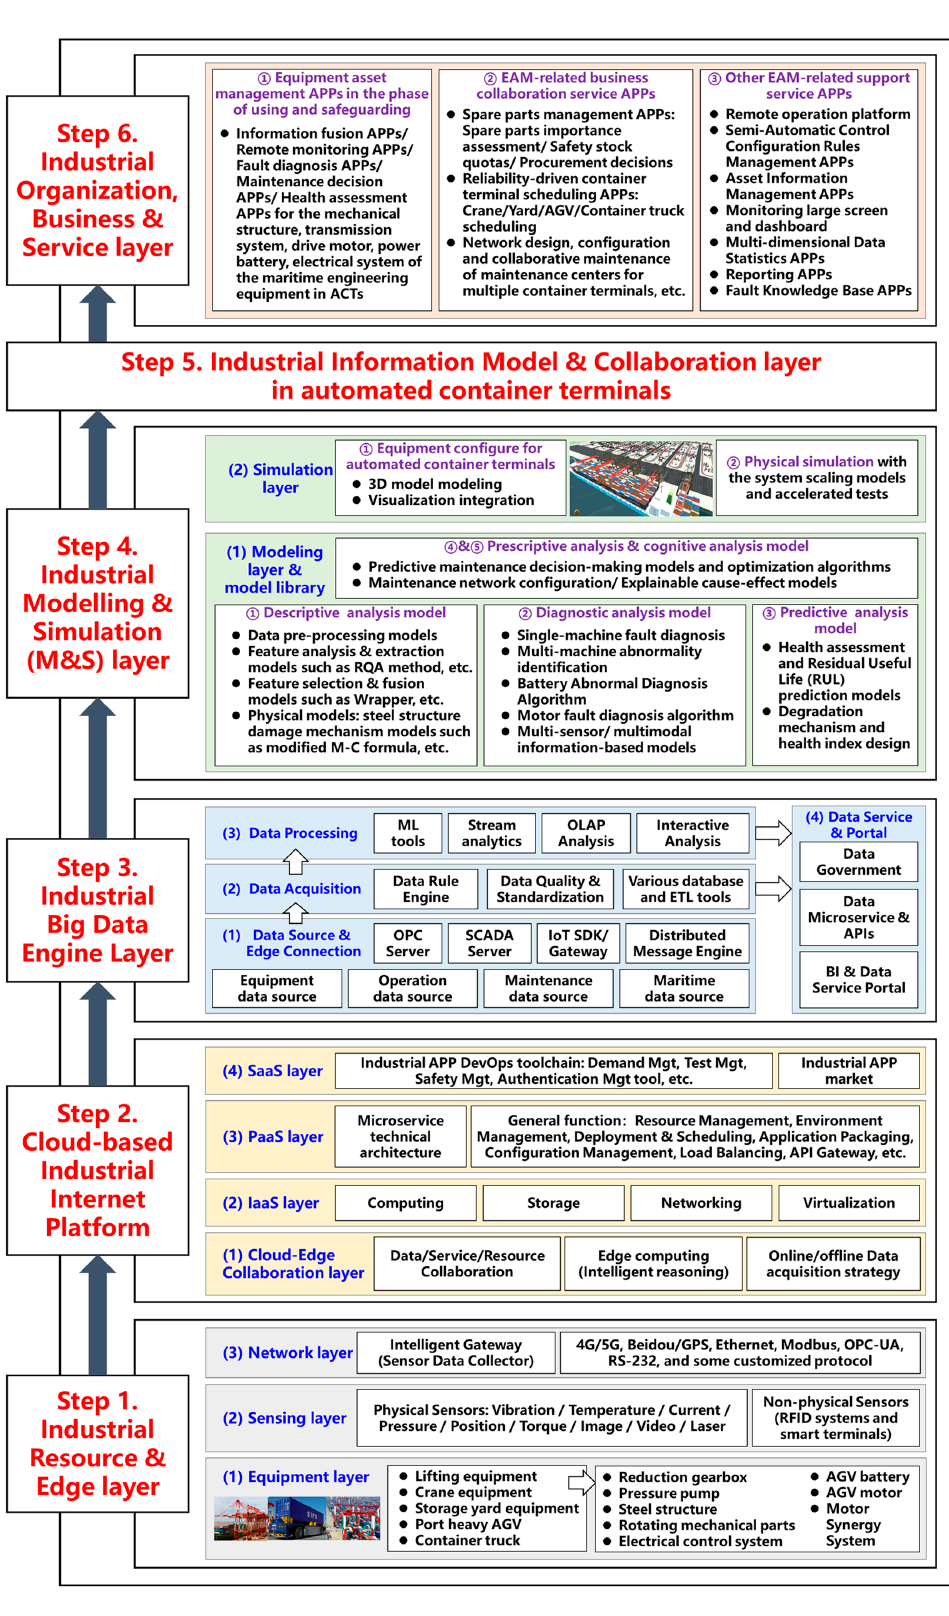
Figure 11. Reference architecture for the I3EAM implementation in automated container terminals.